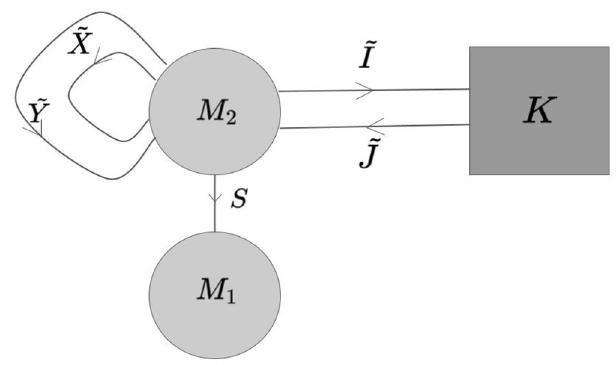
Figure 5 . A fiber of quiver